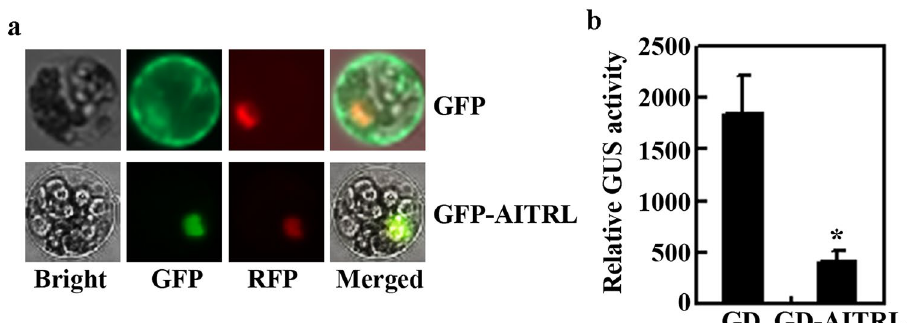
Figure 3. AITRL is a transcription repressor. ( a ) Subcellular localization of AITRL. Plasmids of the GFP-AITRL effector gene and the NLS-RFP nuclear marker gene were co-transfected into Arabidopsis protoplasts isolated from leaves of the Col wild type. The transfected protoplasts were incubated in darkness at room temperature for 16–18 h. The GFP and RFP fluorescence was observed under a fluorescence microscope. Co-transfection of GFP effector gene and the NLS-RFP nuclear marker gene was use as a control. ( b ) Transcriptional activities of AITRL. Plasmids of the LexA-Gal4:GUS reporter gene, the LD-VP transcription activator gene and the GD-AITRL effector gene were co-transfected into Arabidopsis protoplasts isolated from leaves of the Col wild type plants. Co-transfection of the GD effector gene was used as a control. The transfected protoplasts were incubated in darkness at room temperature for 20–22 h. GUS activities were measured by using a microplate reader. Data represent the mean ± SD of three replicates. *Significantly different from the GD (p <